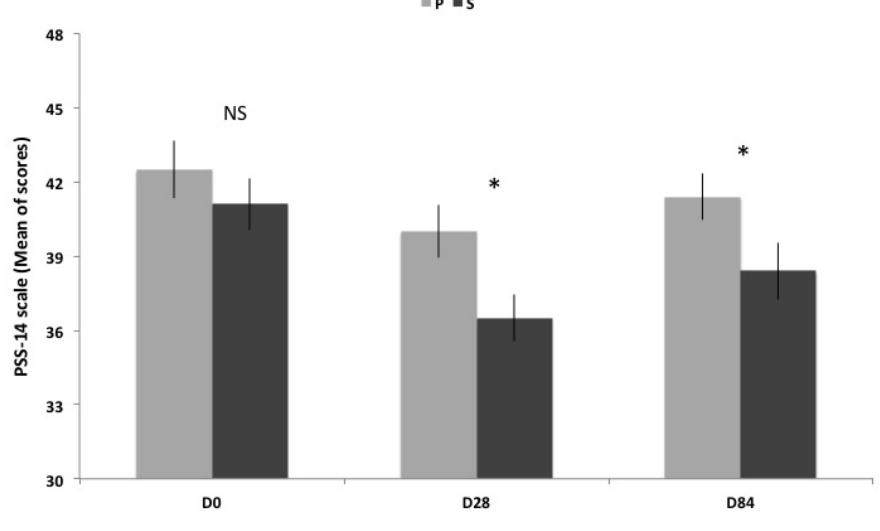
Figure 1. Scores of PSS-14 scale (Mean ± SEM) before, between and after supplementation. Transverse comparison between groups are not significantly different (NS) for D0, but significantly different (* p < 0.05) for D28 and